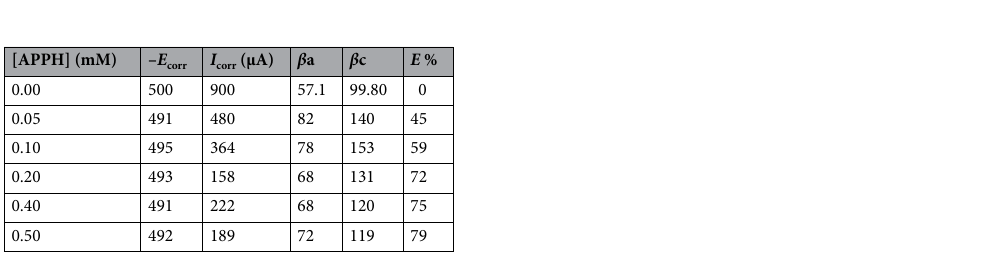
Table 2. Tafel polarization parameters were obtained at different concentrations of APPH for LCS in 0.5 M H 2 SO 4 at 303